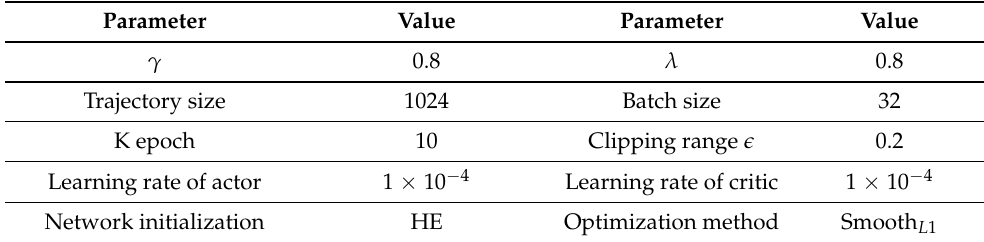
Table 4. Training hyperparameters.